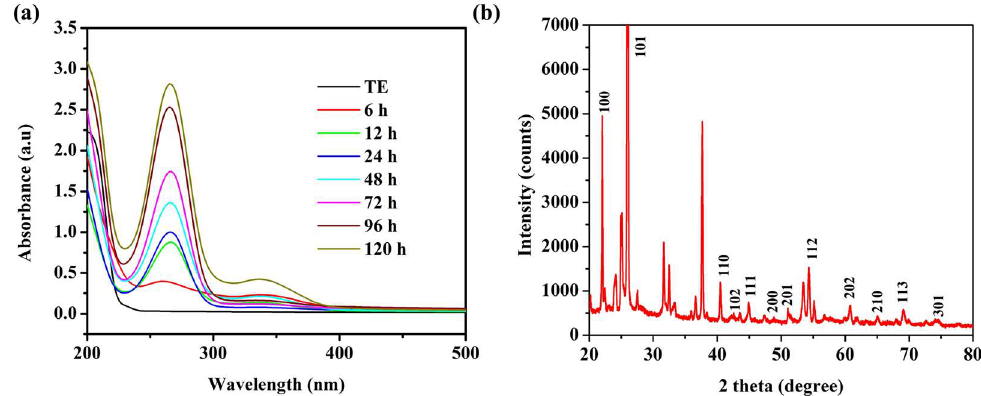
Figure 1. UV–Vis spectrophotometer analysis ( a ), and X-ray diffraction (XRD) pattern analysis ( b ) of selenium nanoparticles (SeNPs); TE— Trichoderma extract.